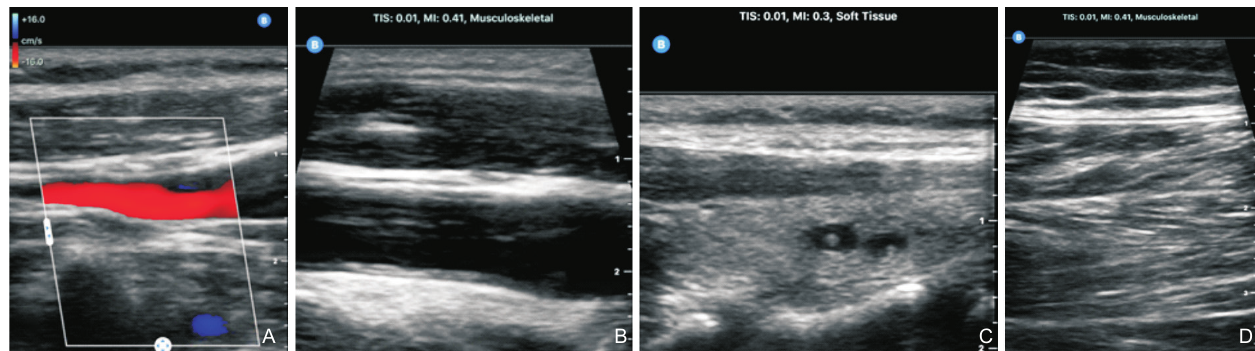
A B C Figure 4 By choosing vascular or superficial scanning application, Butterfly iQ displayed the carotid artery in color Doppler imaging (A), the thickening of the carotid wall in gray-scale imaging (B), the thyroid with colloidal cysts (C), and normal imaging of calf muscle (D).